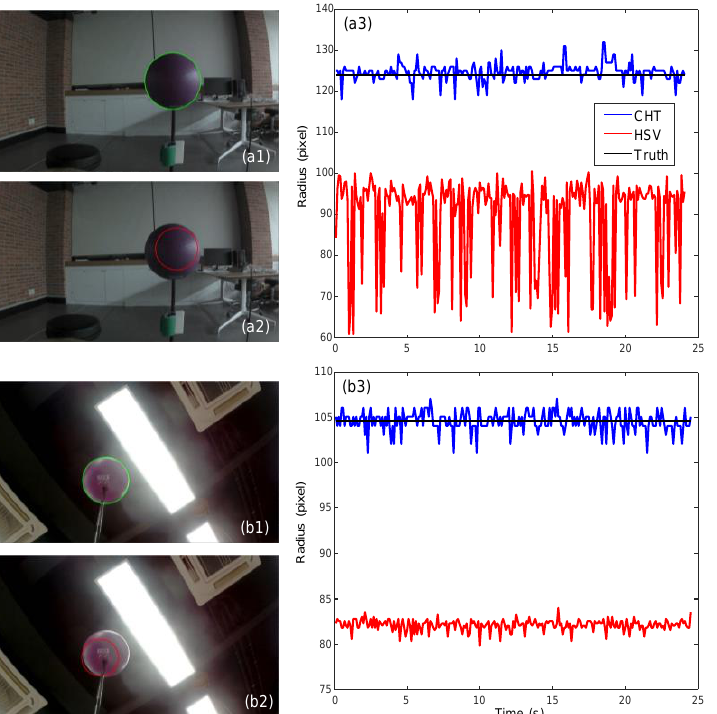
Table 1. MAE of the HSV Filter and the newly developed algorithm.